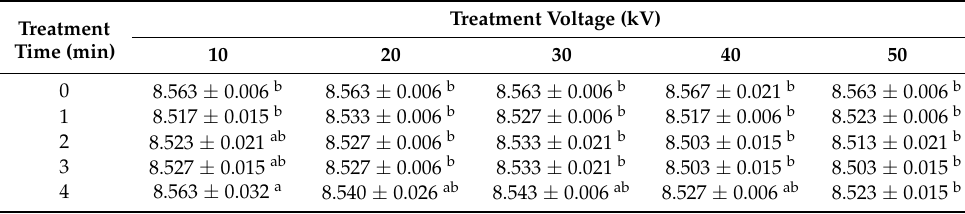
Table 3. Effect of ACP on pH of purified trypsin at different treatment times and voltage. Treatment Time